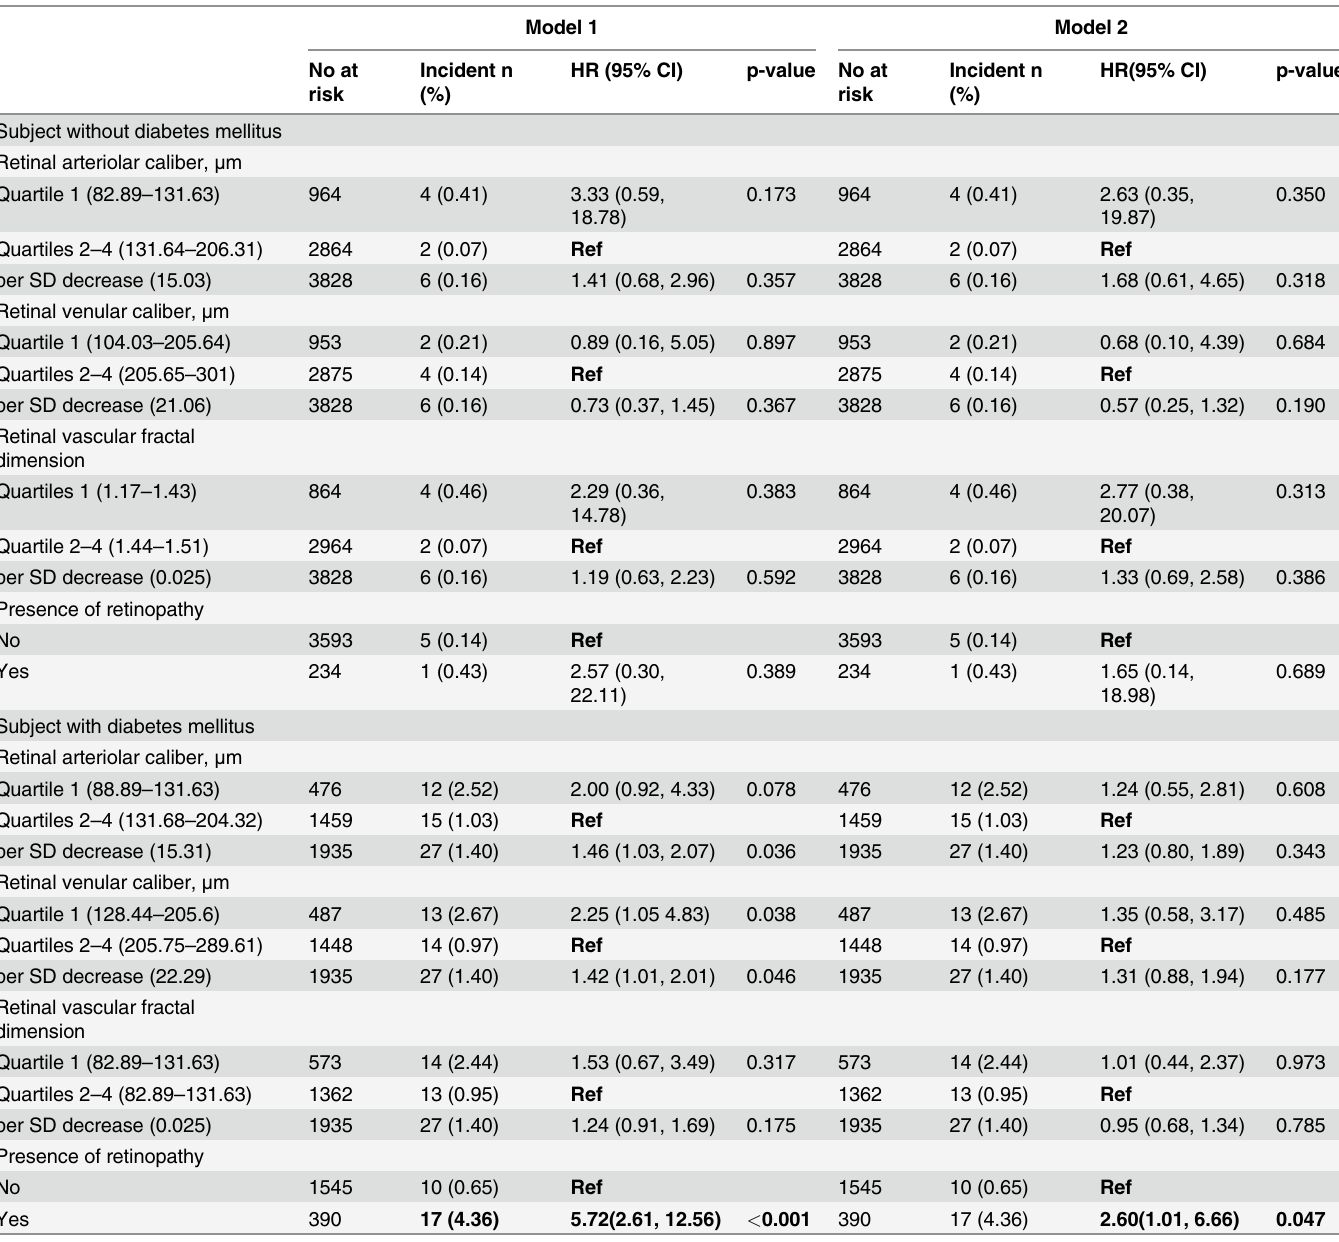
Table 5. Relation of retinal vascular caliber, retinal vascular fractal dimension and retinopathy signs to risk of end stage renal